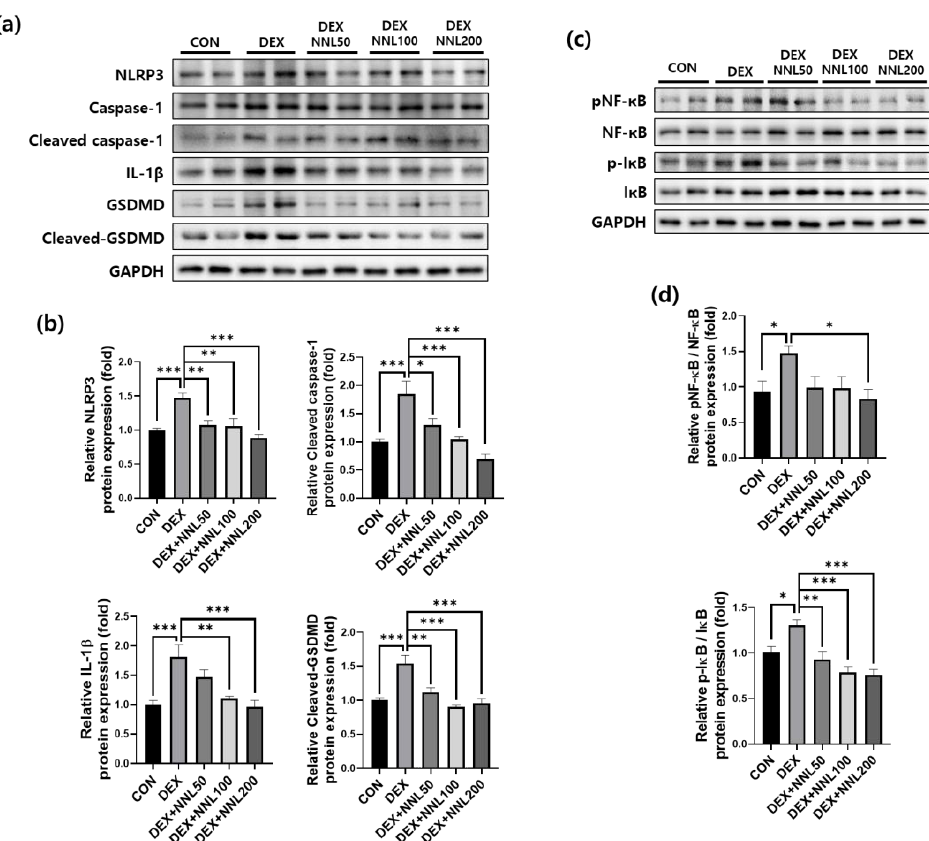
Figure 8. The NNL extract decreased the expression of pyroptosis factors in DEX-treated C2C12 myotubes. Differentiated C2C12 myotubes were treated with 50, 100, and 200 µ g/mL NNL extract for 24 h in the presence of DEX (100 μM). ( a,b ) The protein expression levels of NLRP3, cleaved caspase-1, IL-1 β , and cleaved-GSDMD were analyzed by immunoblotting, quantified using ImageJ software, and normalized to GAPDH. ( c,d ) The protein expression levels of pNF- κ B and p-I κ B were analyzed by immunoblotting, quantified using ImageJ software, and normalized to NF- κ B and I κ B, respectively. Representative images ( a,c ) and quantitative analysis bar graphs ( b,d ) are shown. Data are shown as the mean ±S.E.M., n = 6/group; * p < 0.05, ** p < 0.01, *** p < 0.001.